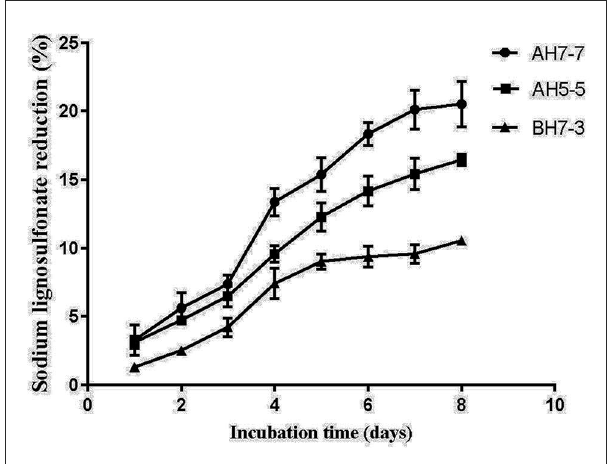
FIGURE1 Sodium ligninsulfonate reduction by three strains.